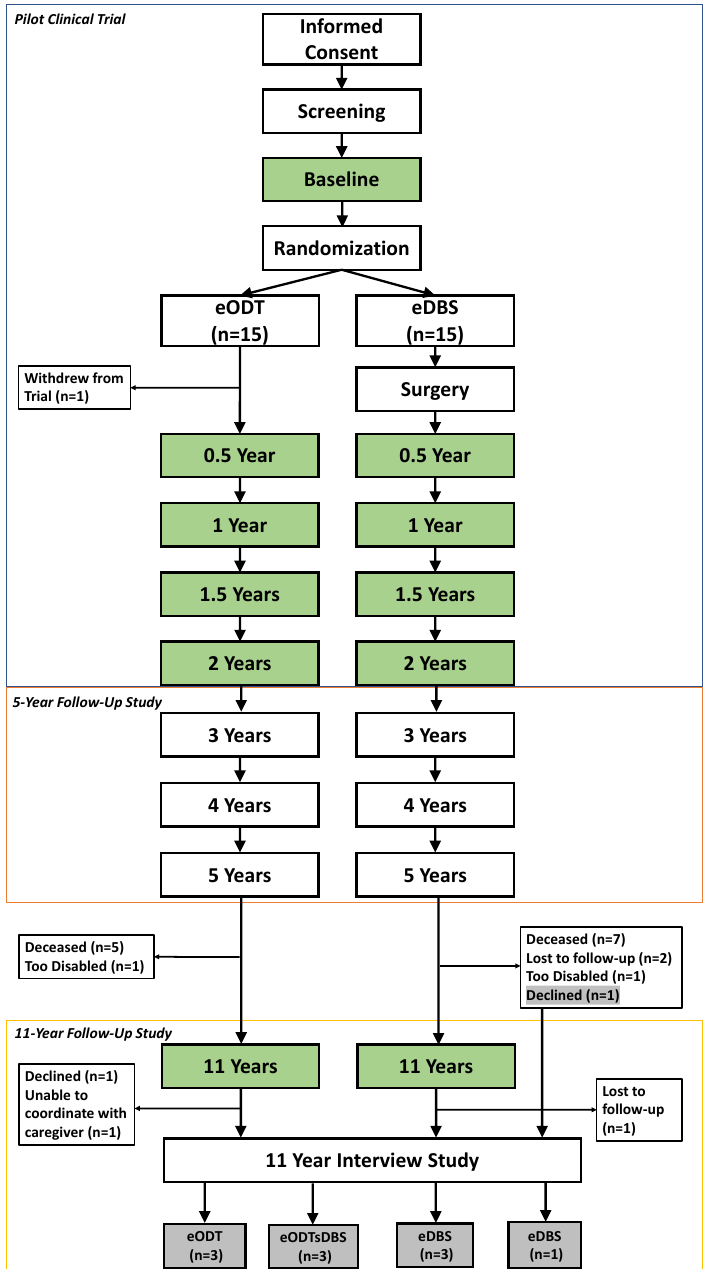
Figure 1. DBS in early PD pilot trial participants in this 11-year interview study. Thirty partici- pants enrolled in the pilot clinical trial and were randomized 1:1 to receive bilateral subthalamic nucleus deep brain stimulation (eDBS) plus optimal drug therapy (ODT) or ODT alone (eODT) and followed for two years. Week-long therapeutic washouts (green boxes) were conducted every six months during the two-year trial. All participants who completed the trial enrolled in a five-year follow-up study. Twelve patients completed an 11-year study visit, which included the week-long therapeutic washout (green boxes). Ten patients from the DBS in early-stage PD pilot clinical trial participated in this 11-year interview study. eODTsDBS = randomized to early ODT and later re- ceived DBS as standard of care after the trial completed.